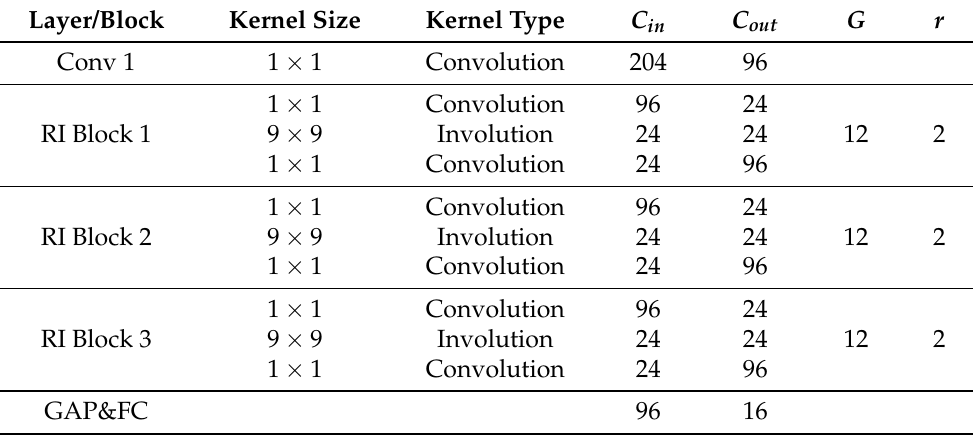
Table 1. Proposed DRIN topology for the Salinas Valley dataset, C in is the input channel number, C out is the output channel number, and G and r represent the group number and reduction ratio,